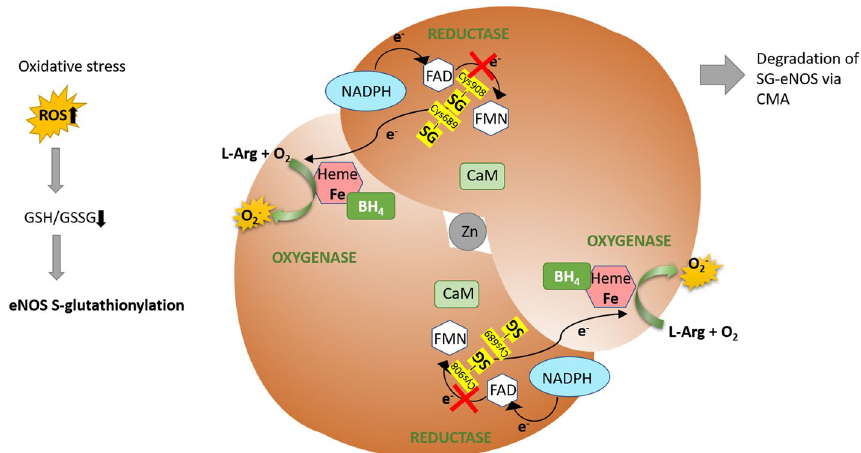
Fig. 4 eNOS uncoupling due to eNOS S‑glutathionylation. Oxidative stress decreases the cellular GSH/ GSSG ratio, leading to protein S‑glutathionylation. Glutathionylated cysteine residues (Cys689 and Cys908) of eNOS are located at the interface of the FAD and FMN binding sites, thus disrupting FAD‑FMN alignment and electron transfer between flavins, which causes the transfer of an electron to molecular oxygen and the production of a superoxide radical instead of NO. Prolonged retention of S‑glutathionylated eNOS (SG‑eNOS) in the cytoplasm can result in its degradation via chaperone‑mediated autophagy (CMA), leading to irreversible loss of